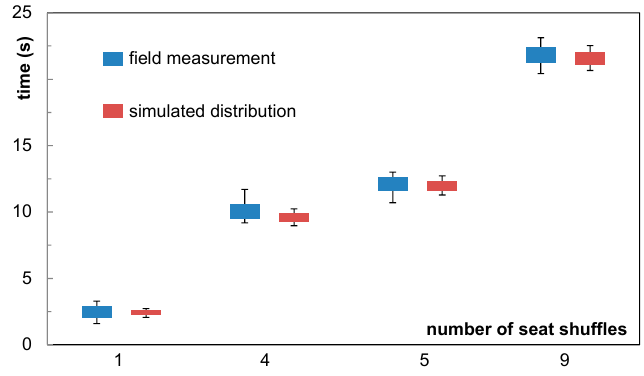
Figure 12. Seat interference: measurement vs. simulation.